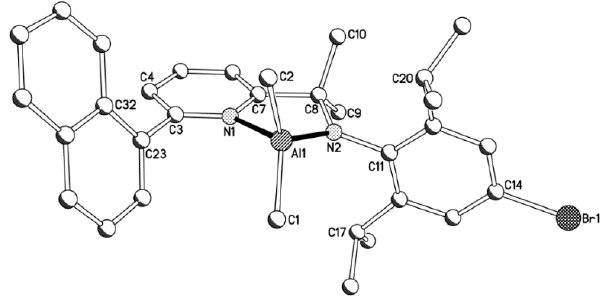
Figure 3. Molecular structure of 1c with atom labeling scheme. All hydrogen atoms have been omitted for clarity.